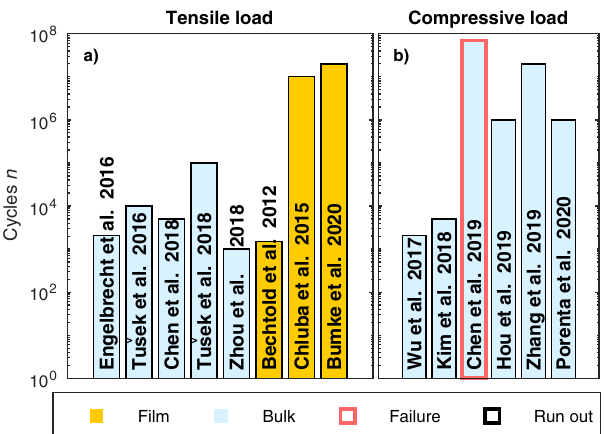
Fig. 1 Long-term stability of nickel-titanium based alloys quanti fi ed in material-test-setups. Only results of samples that lasted at least 10 3 cycles are shown. The maximum number of cycles measured experimentally are shown for tensile in ( a ) and compressive loading in ( b ). Film samples are indicated in yellow. A red frame marks a sample that failed at the end of the test. Bars with a black frame indicate tests that were stopped after a certain number of cycles without detection of material failure (runout). Material composition, sample shape, amount of material, stress, strain, frequency and temperature vary for each sample 8 – 11,13,25 – 33